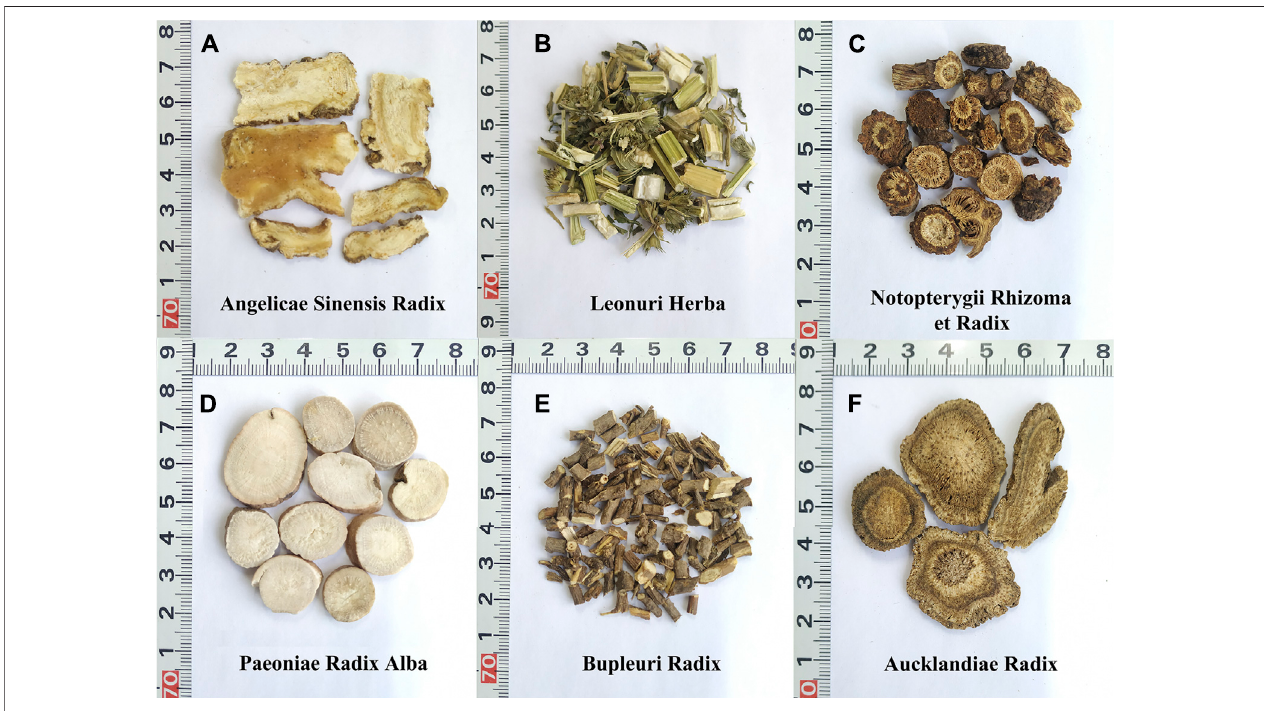
FIGURE 1 | The morphological characteristics of the six herbal materials in FKDSW. (A) Angelicae Sinensis Radix (Danggui). (B) Leonuri Herba (Yimucao). (C) Notopterygii Rhizoma et Radix (Qianghuo). (D) Paeoniae Radix Alba (Baishao). (E) Bupleuri Radix (Chaihu). (F) Aucklandiae Radix (Muxiang).